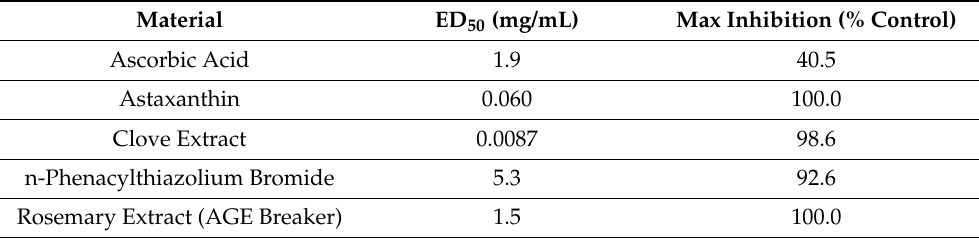
Table 1. Summary of Biofilm Inhibition